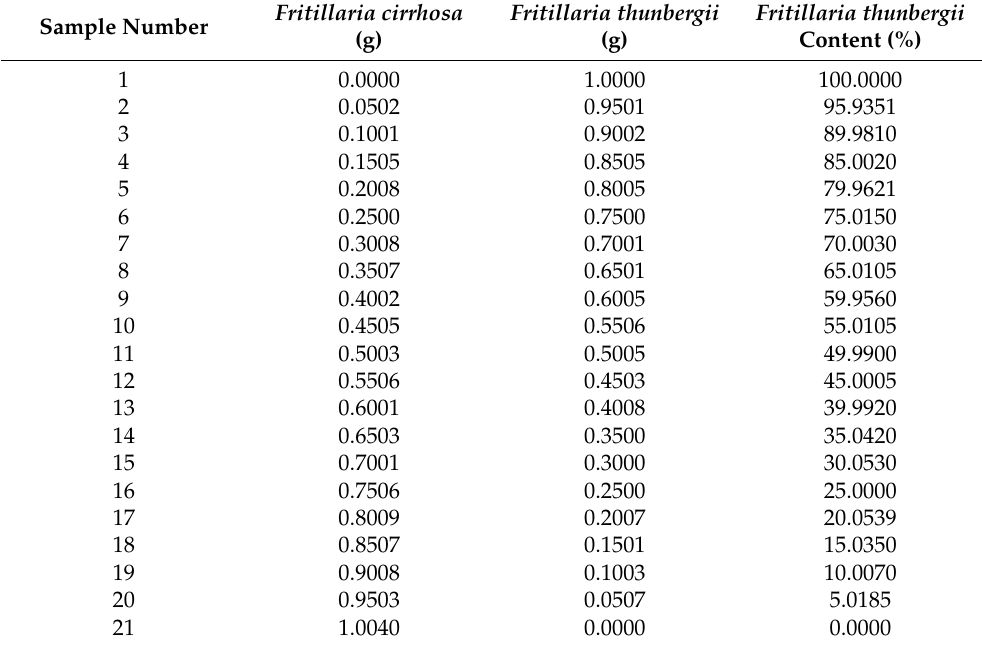
Table 1. Experimental samples of 21 different doping